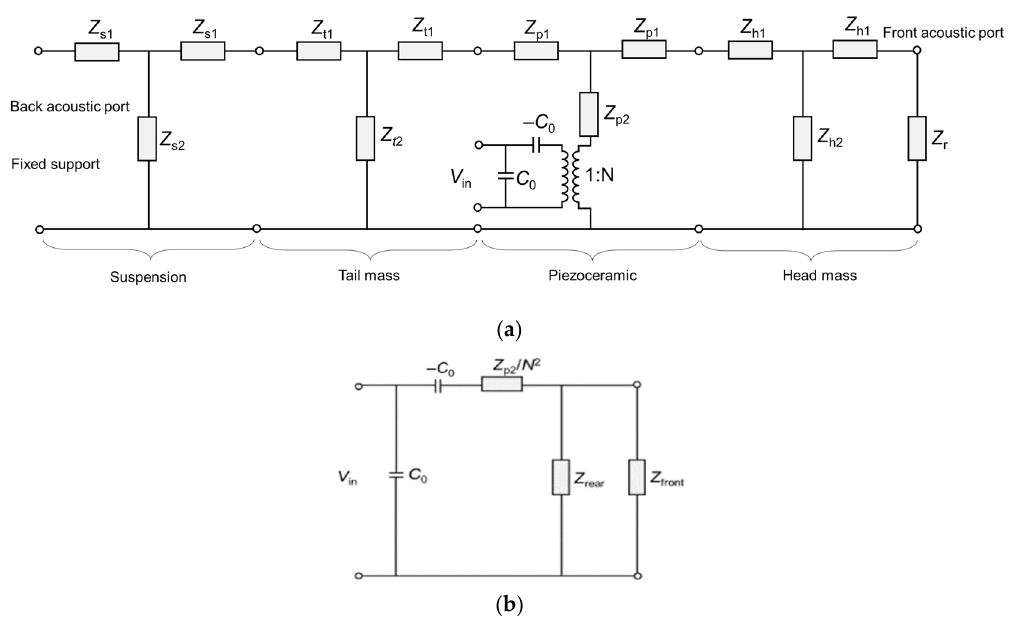
Figure 3. Schematic representation of the equivalent circuit of the rear-mounted Tonpilz transducer. The load elements are defined in Table 2: ( a ) distributed equivalent circuit model; ( b ) rearrangement of the circuit in ( a ) with combined loads. All load impedance elements are referred to as the electrical side.